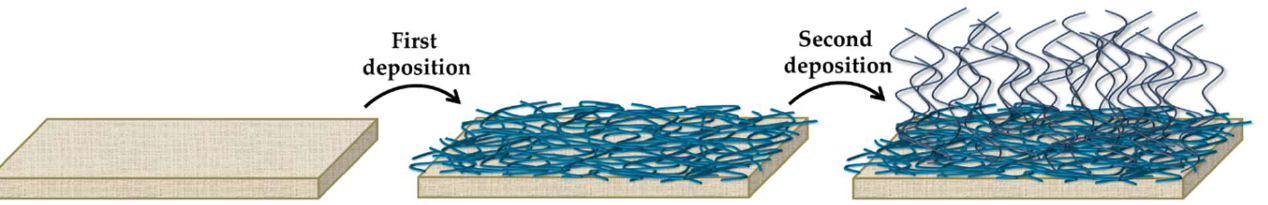
Figure 4. Double sol–gel-based coating application for the development of the treated functional cotton fabrics.